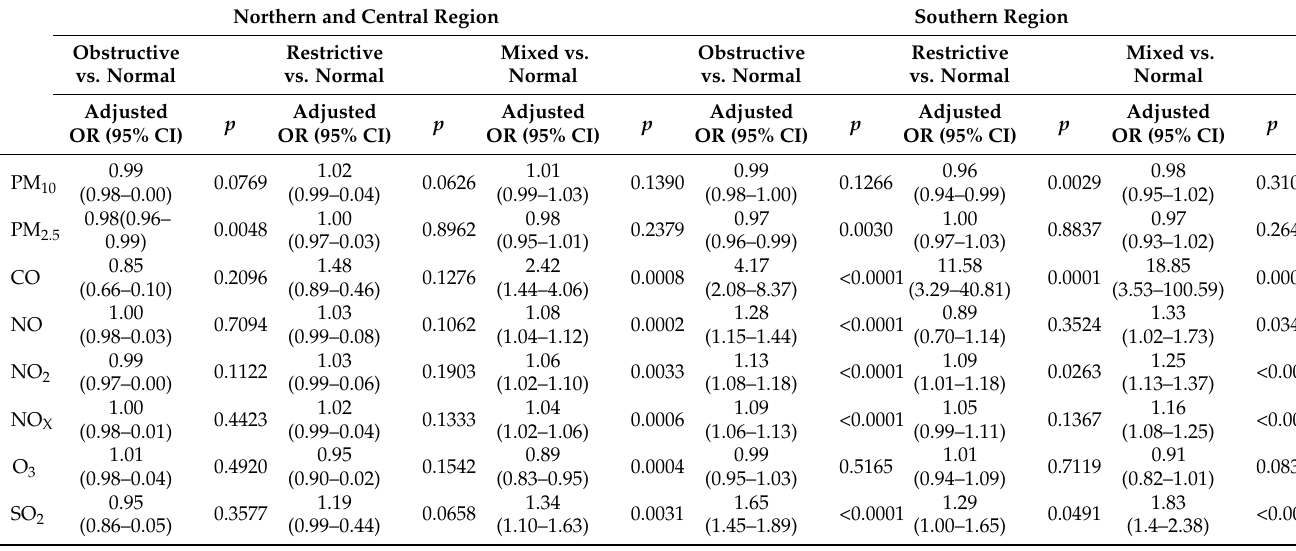
Table 4. Interactions among monitoring area and air